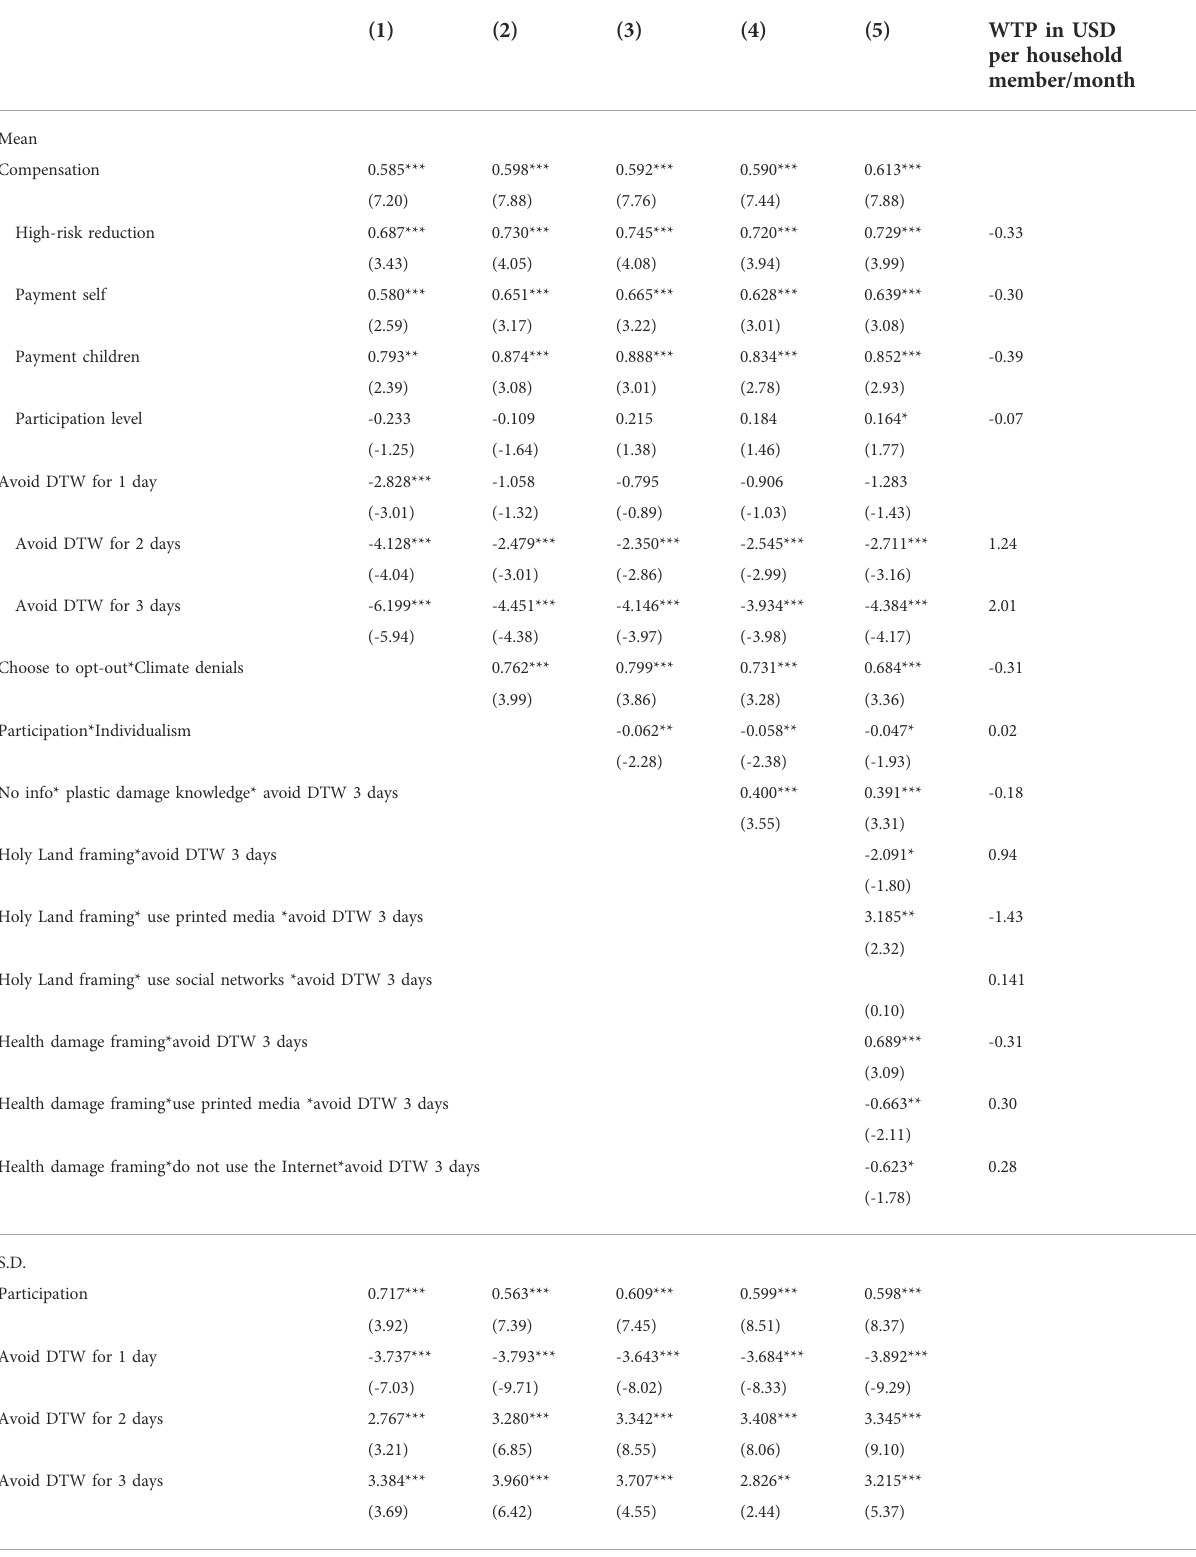
TABLE 4 Results of the mixed-logit